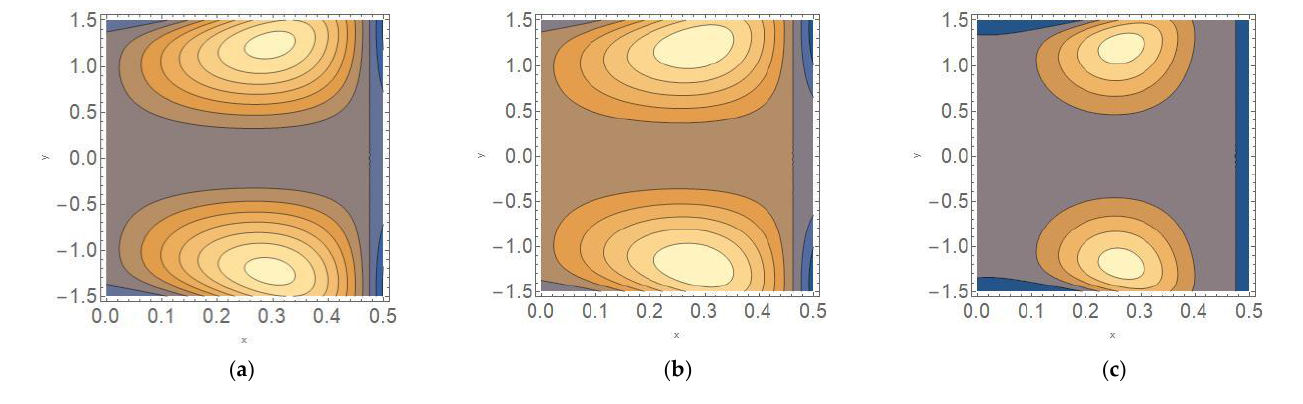
Figure 8. ( a – c ). Streamlines for ( a ) M = 1, ( b ) M = 2, ( c ) M = 3 G rT = 0.5,